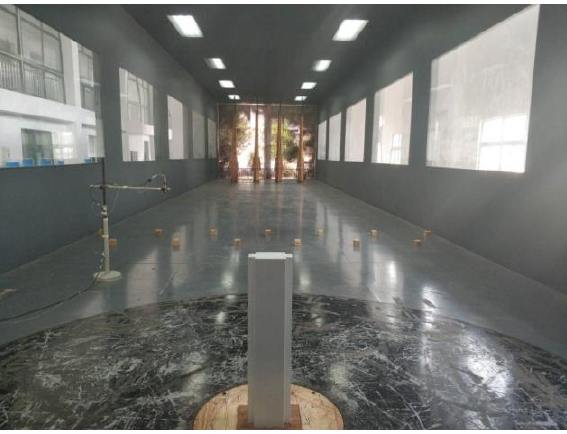
Figure 3. The test model.